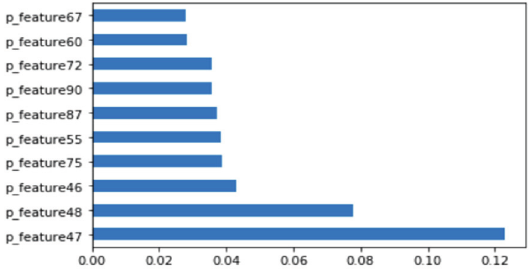
Figure 17. Top 10 features of Windows and Linux Binary. Table 12. Classification Performance of Windows and Linux binary.